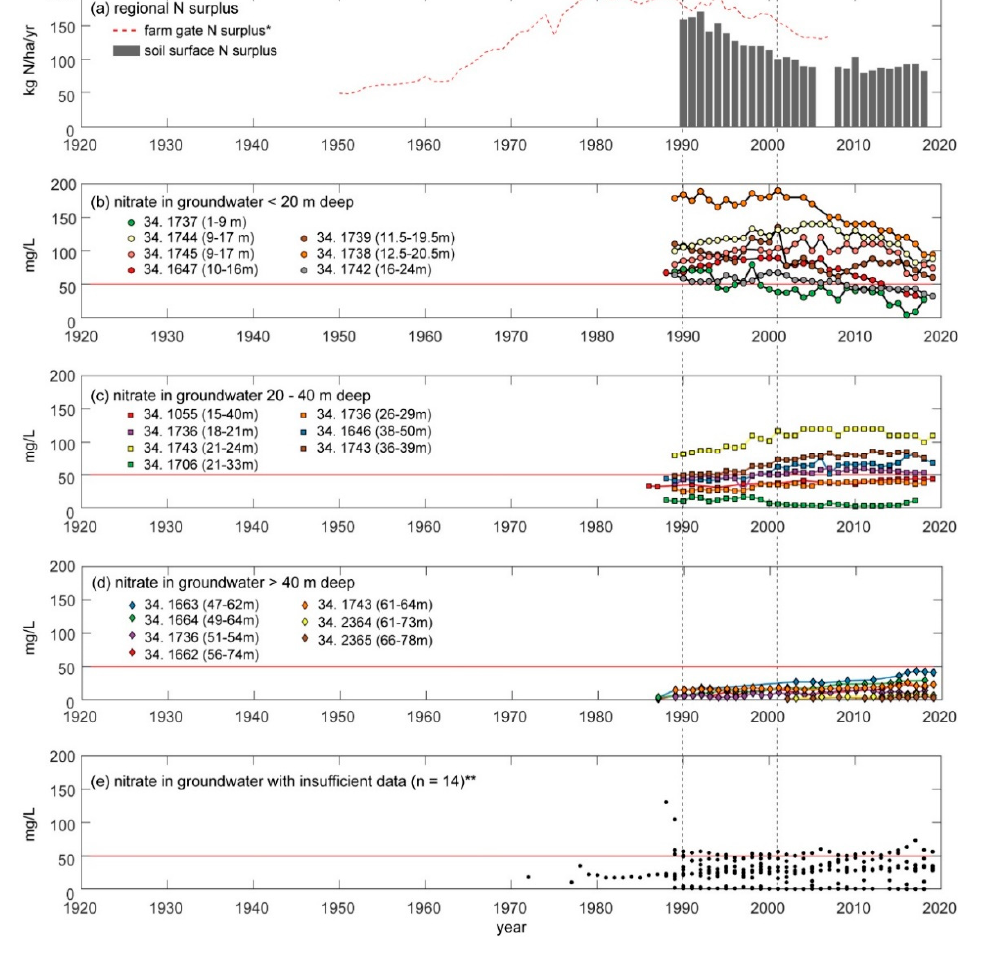
Figure 5. Overview of regional N surpluses and annual averages concentrations of nitrate in groundwater of Aalborg-Drastrup. The soil surface N surplus and farm gate N surplus at the regional scale (* Hansen et al. [50]) are shown in ( a ). The annual average concentrations of nitrate of shallow (filter interval < 20 m), middle (filter interval between 20 and 40 m), and deep groundwater (filter interval deeper than 40 m) are shown in ( b – d ), respectively. Those of groundwater with insufficient data and no temporal variability are shown in ( e ). The annotations in the figure are the same as those of Figure 4. ** number of groundwater wells.